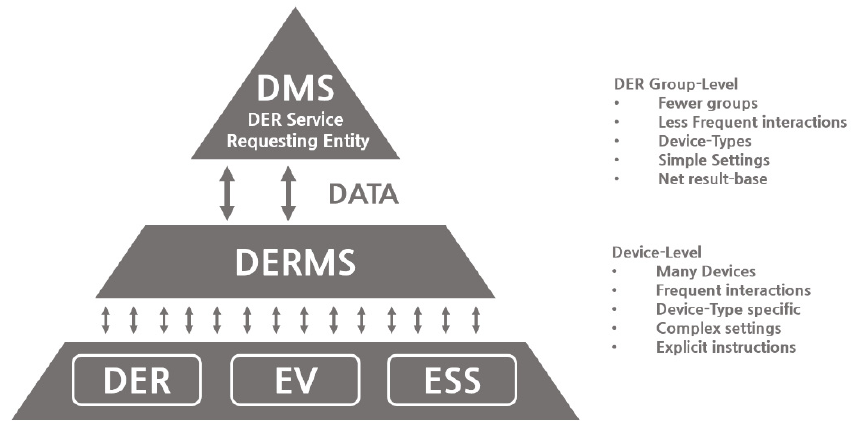
Figure 9. Connectivity of DERMS.